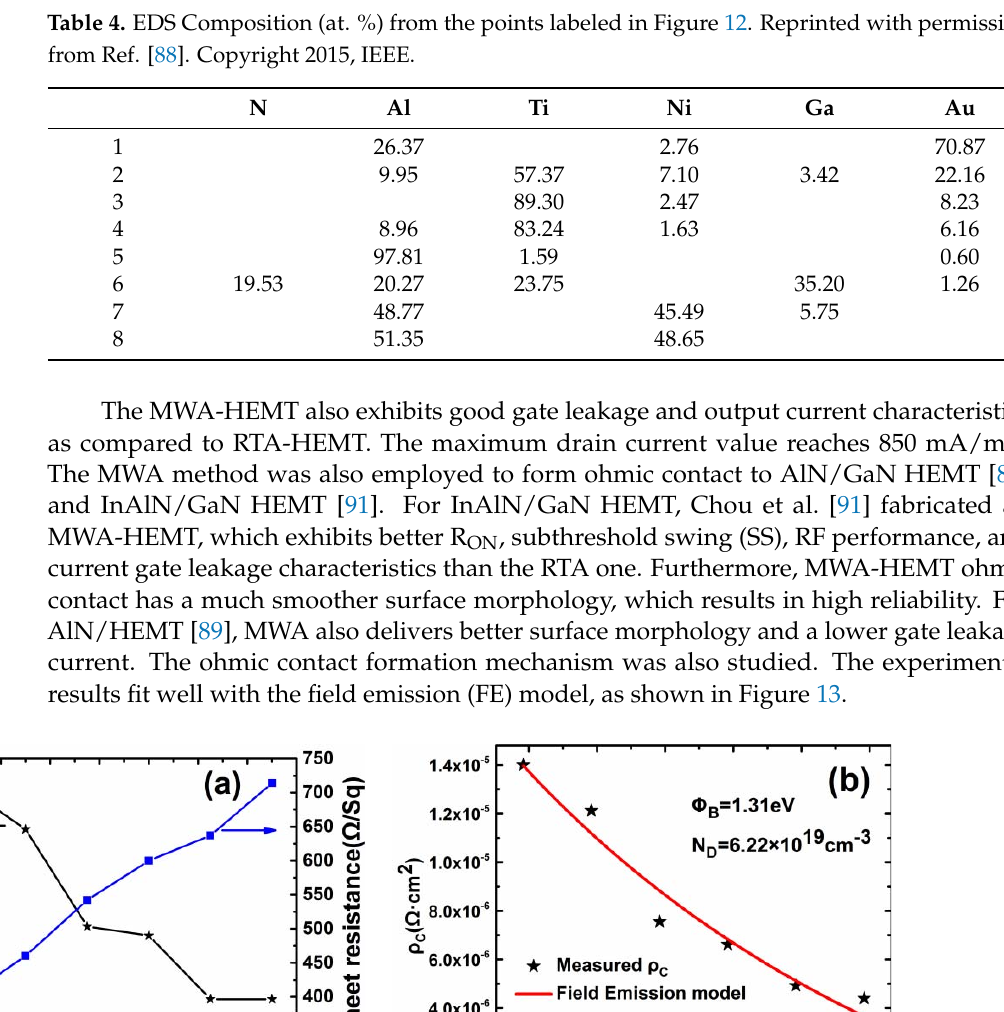
Table 5. GaN-based HEMTs devices’ electrical characteristics: MWA vs. RTA [88–91]. Temperature Material Methods